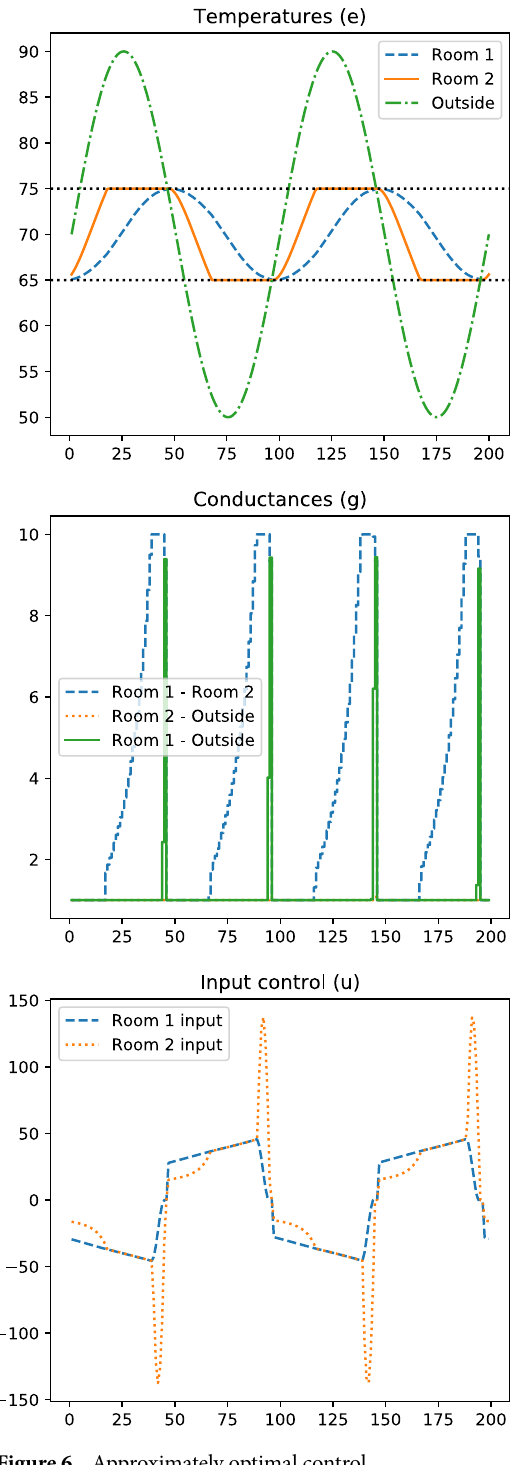
Figure 6. Approximately optimal